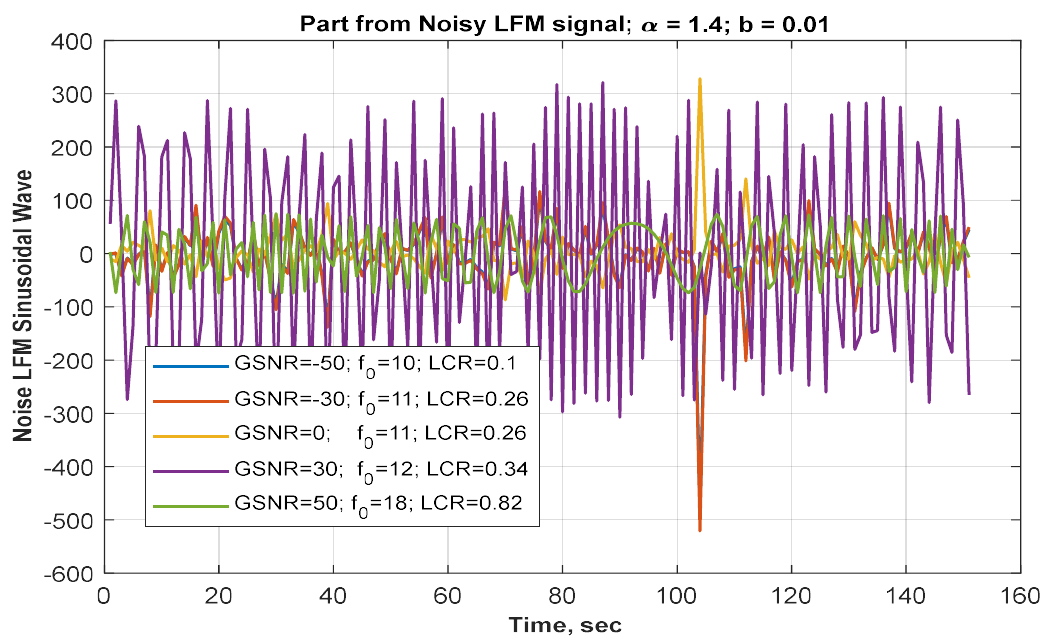
Figure 37. 1D-signals in time domain with different frequency, LCR, and GSNR.